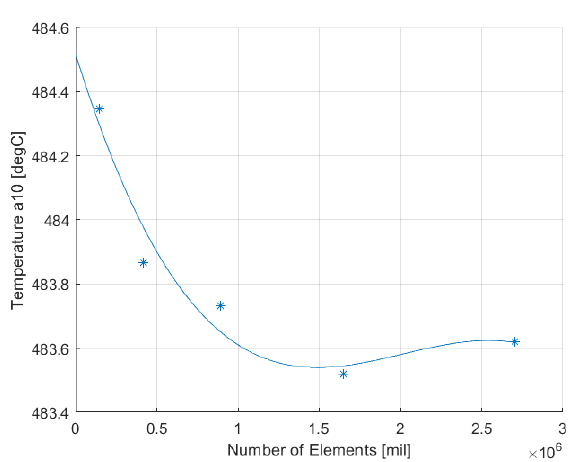
Fig. 12. Convergence analysis of the solved mesh of the model .